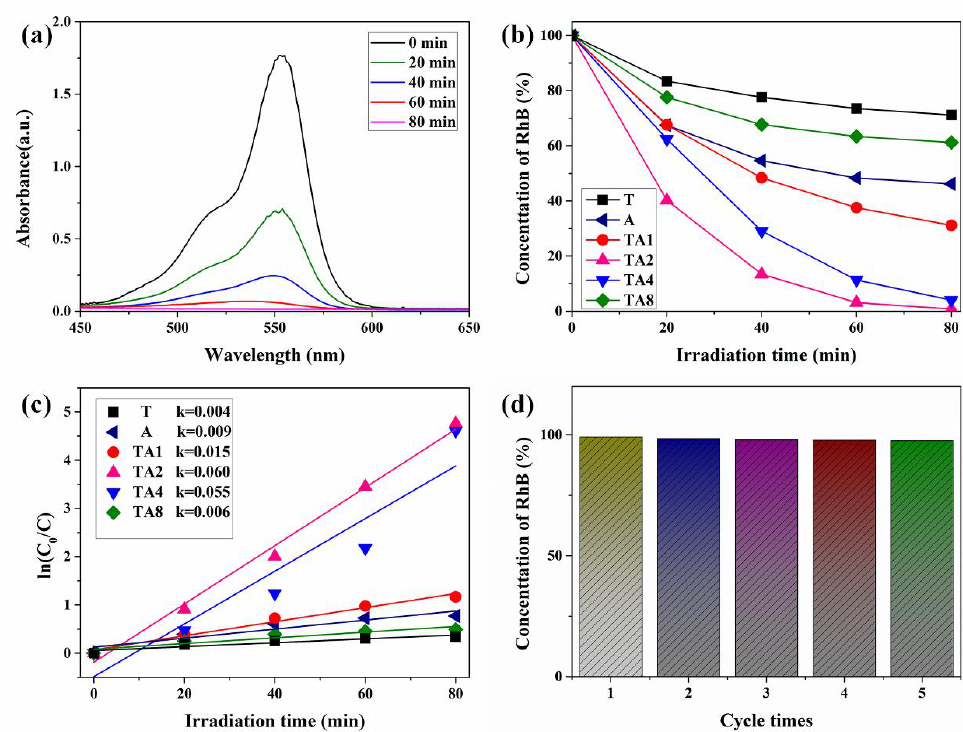
Figure 6. ( a ) Absorption spectral changes of RhB solution with TA2 under visible light irradiation, ( b ) comparison of photocatalytic degradation of RhB and ( c ) the photodegradation rates of samples under visible light irradiation, ( d ) cycling photocatalytic performances of TA2 under visible light irradiation.